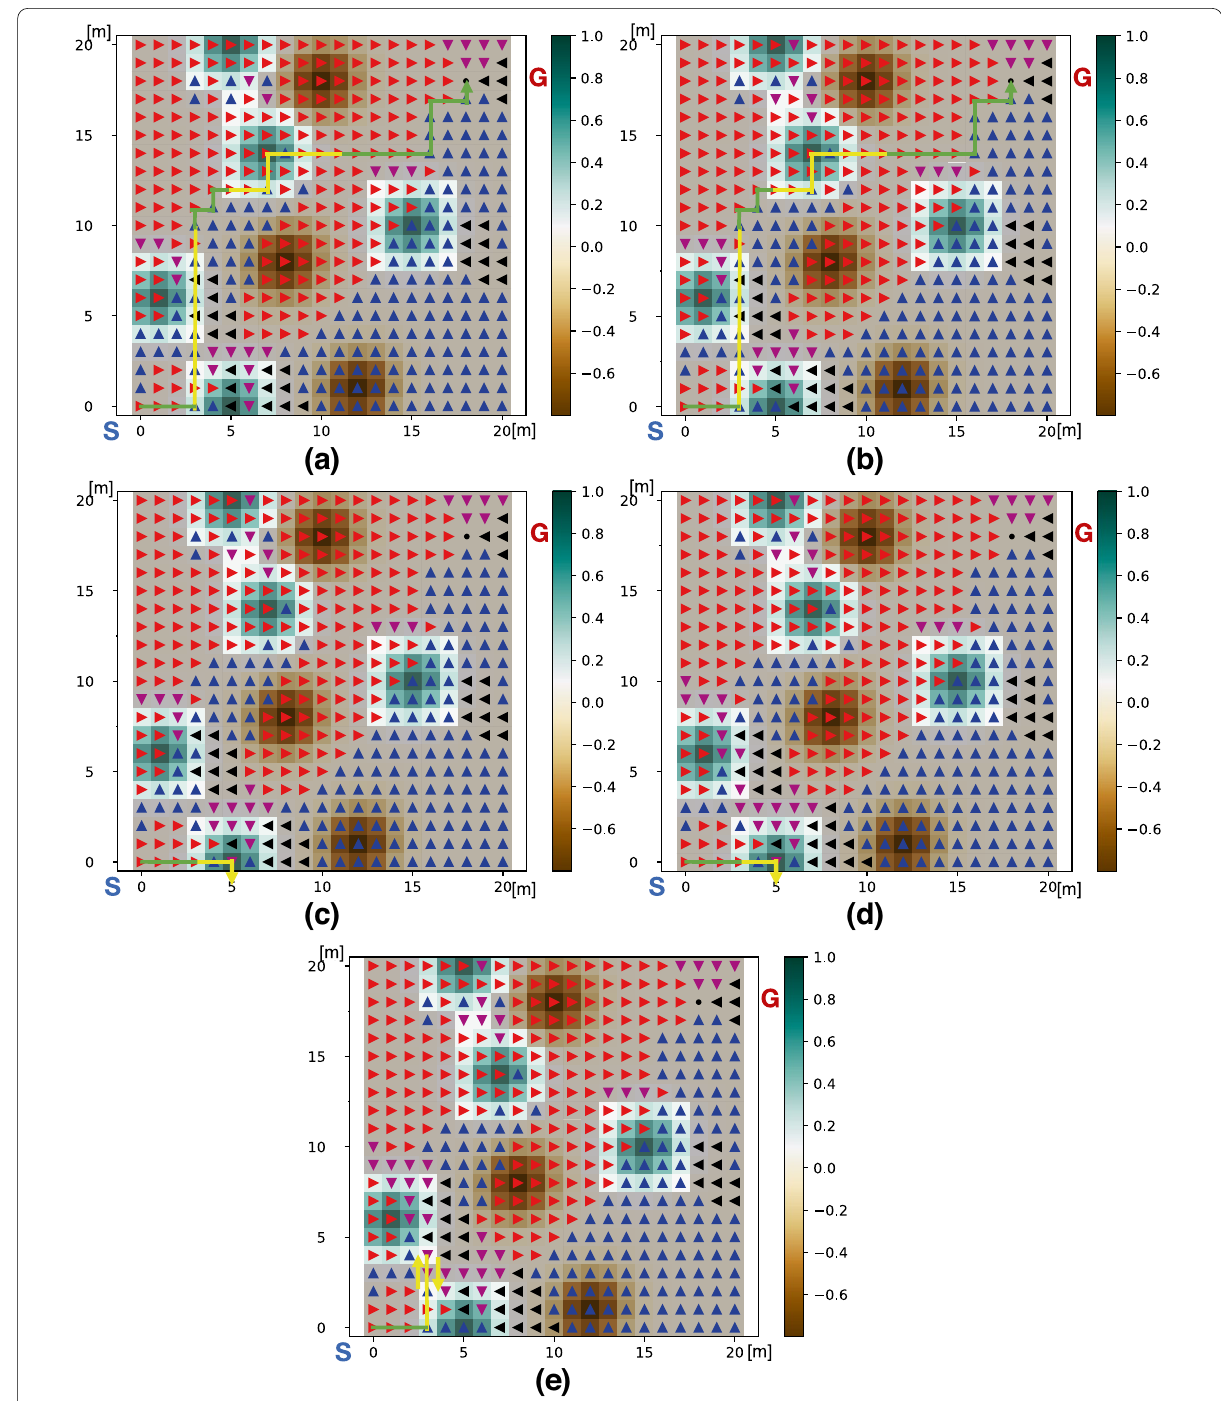
Fig. 9 The path planning results on sandy terrain (2); a : ( w 1 , w 2 ) = ( 0.6,0.4 ) , b : ( w 1 , w 2 ) = ( 0.7,0.3 ) , c : ( w 1 , w 2 ) = ( 0.8,0.2 ) , d : ( w 1 , w 2 ) = ( 0.9,0.1 ) , e : ( w 1 , w 2 ) = ( 1,0